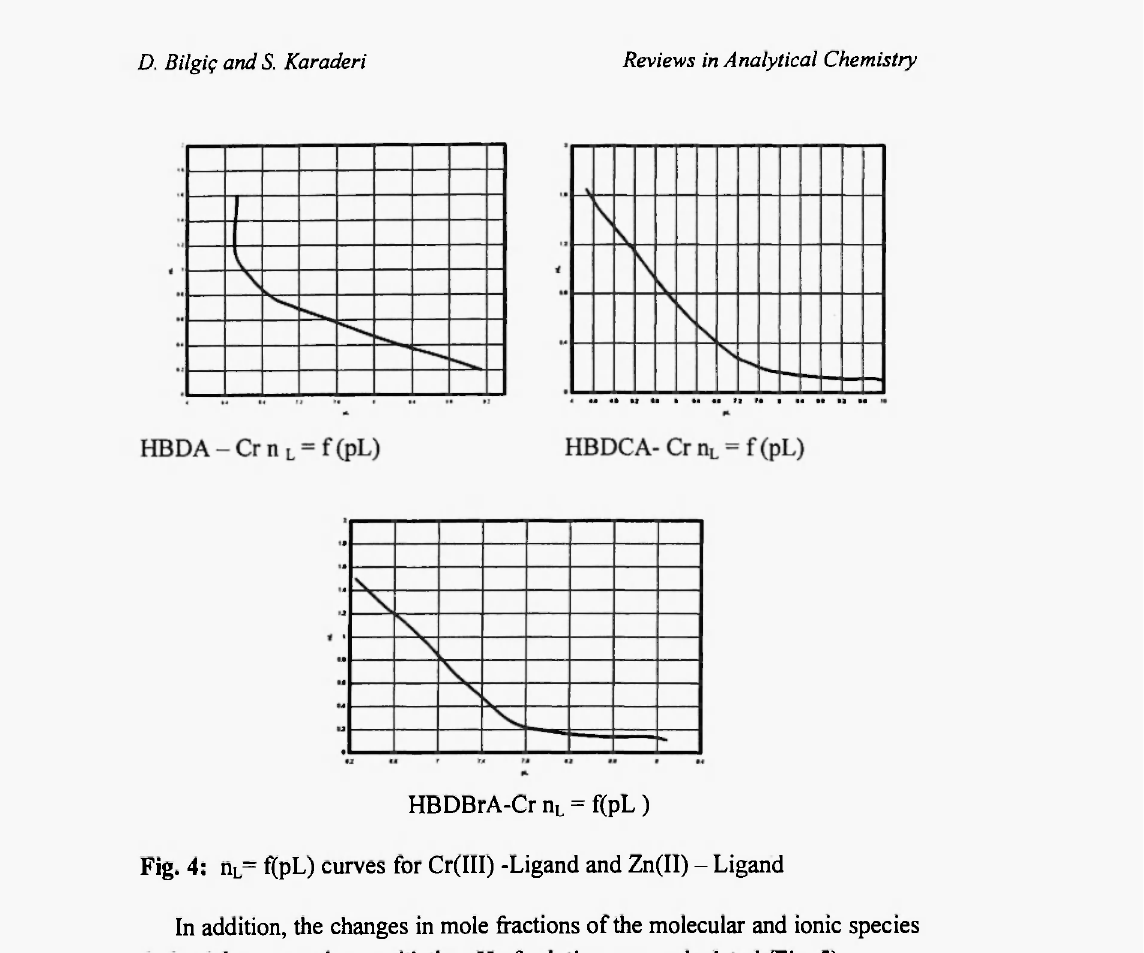
Fig. 4: n L = f(pL) curves for Cr(III) -Ligand and Zn(II) - Ligand In addition, the changes in mole fractions of the molecular and ionic species derived from complexes with the pH of solution were calculated (Fig. 5).